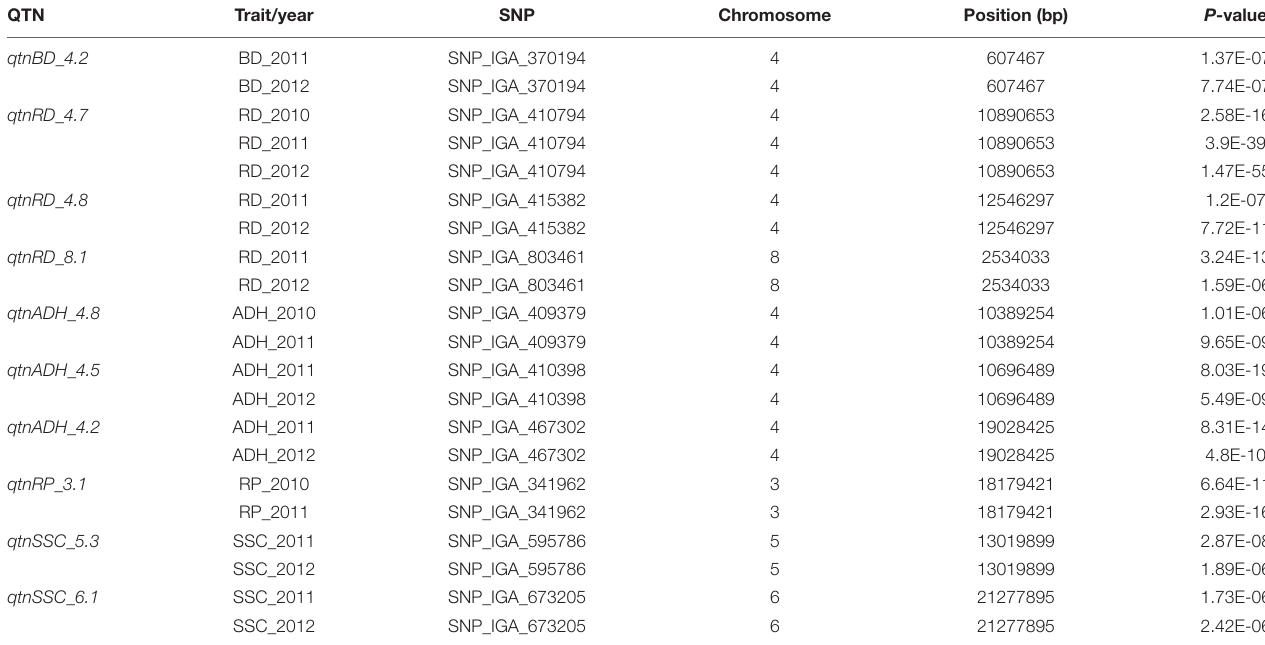
TABLE 3 | Significant associations between SNP markers and fruit quality traits consistently detected in two seasons using